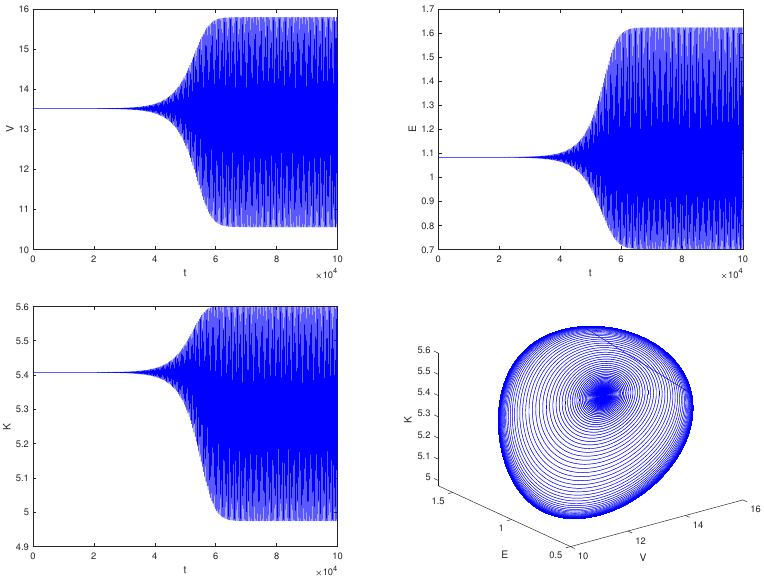
Figure 6. The trajectories and phase graph of system ( 4 ) with τ 1 = 1.00, τ 2 = 6.50, S ∗ is unstable and a stable periodic solution bifurcates from S ∗